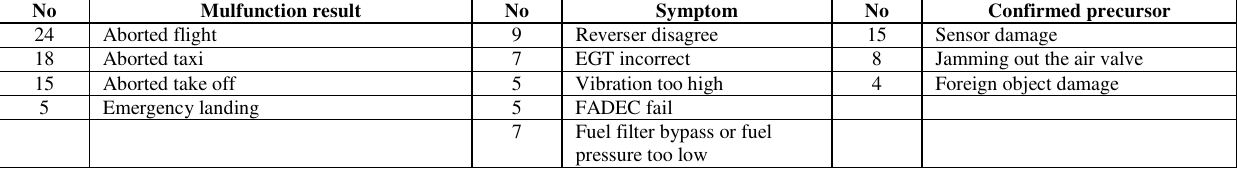
Table 17. Confirmed roots of the jet engines failures which caused aviation